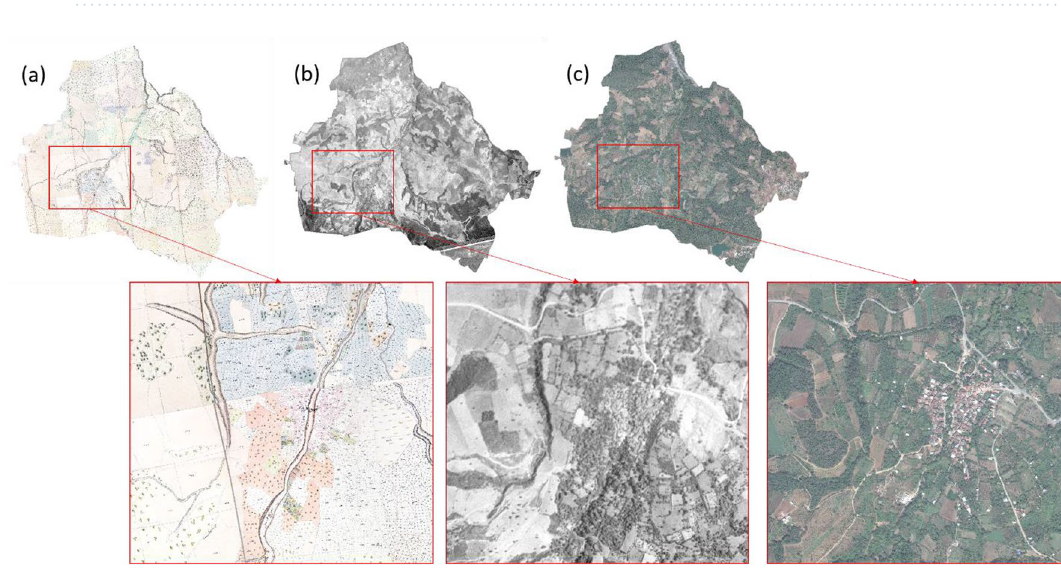
Figure 5. Geospatial dataset for the Aksu study region. ( a ) 1858 Cadastral map, ( b ) 1955 aerial photo, and ( c ) 2020 WV-3 satellite image (finer details shown in the inset images highlighted by red